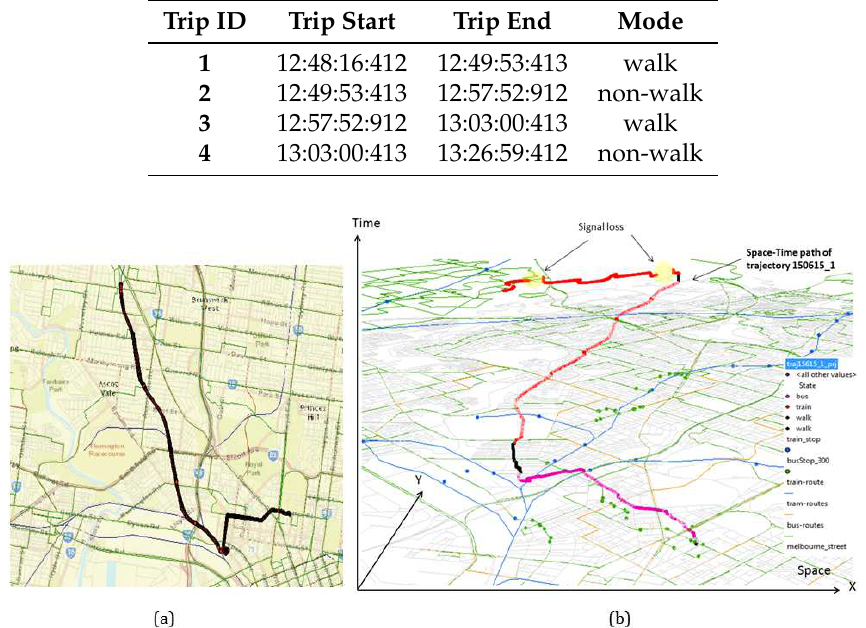
Table 12. Trips generated by a walking-based method on Trajectory ID 150615_1.